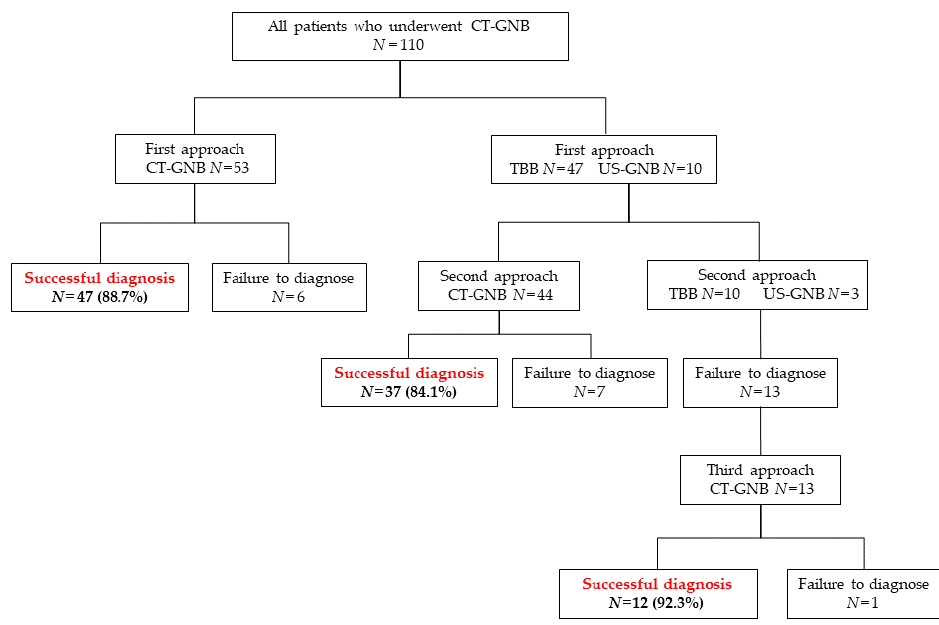
Figure 1. Diagnostic flow of biopsy modality. CT-GNB: Computed tomography-guided needle biopsy, TBB: Transbronchial biopsy, US-GNB: ultrasonography-guided biopsy.